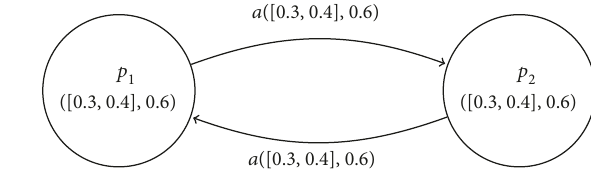
Figure 6: ̂𝜑 is a good subsystem.